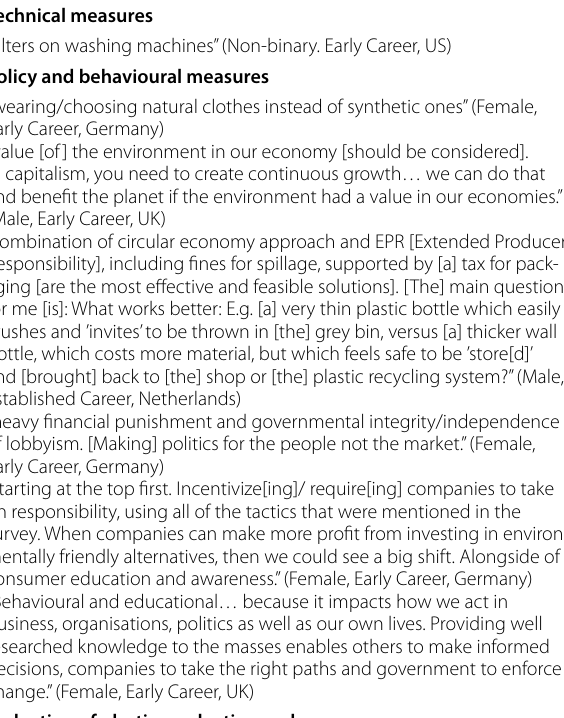
Table 6 Open-ended answers selected to illustrate responses to “In your opinion, what is the most effective and feasible solution to reduce current microplastics